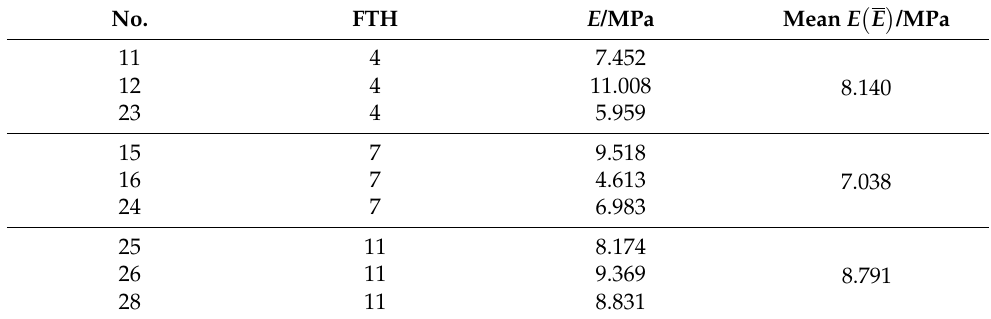
Table 5. The elasticity modulus of each specimen and the mean elasticity modulus of a same FTH. No. FTH E /MPa Mean E